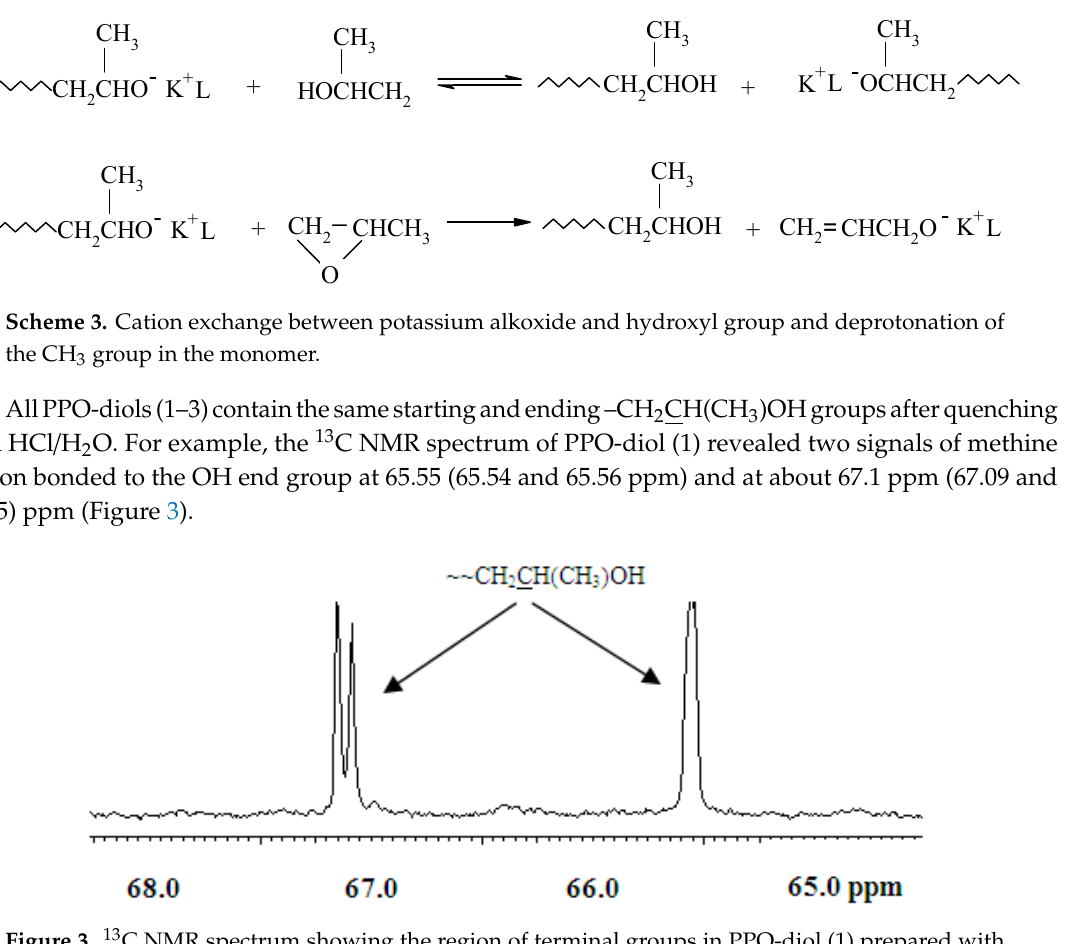
Figure 3. 13 C NMR spectrum showing the region of terminal groups in PPO-diol (1) prepared with K- K-DPG / DPG/L.